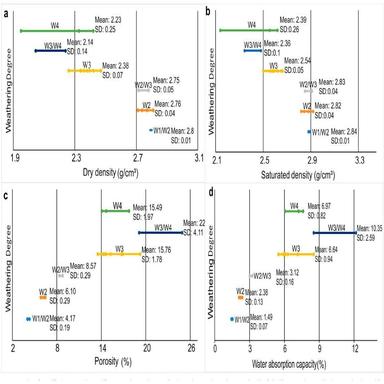
Results of specific dry mass (a), specific saturated mass (b), porosity (c), and water absorption capacity (d) of phyllites. Graphs a and b show a reduction, while c and d an increase with phyllite weathering evolution, being highlighted the mean and standard deviation (SD).